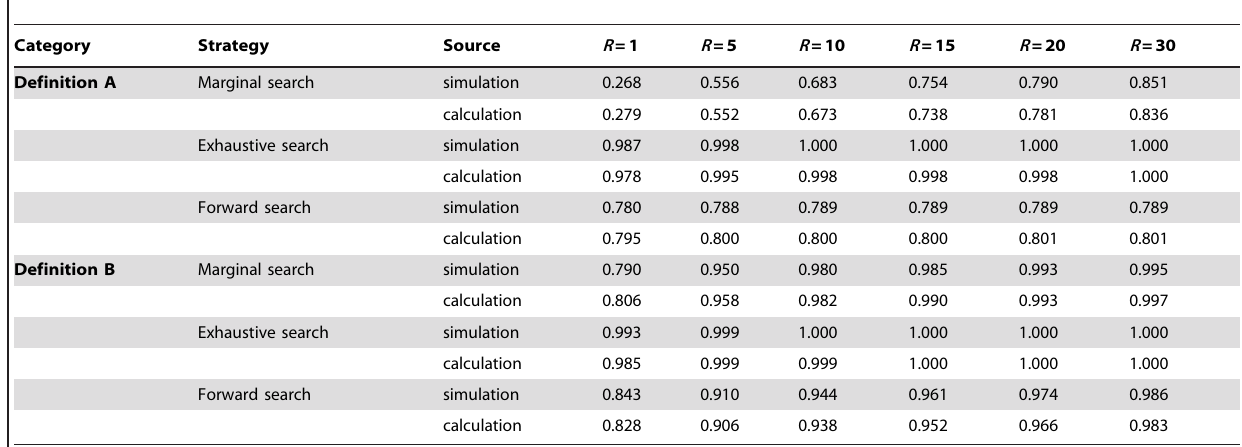
Table 1. The probability of detecting the exact true model (or both true SNPs in marginal search) under power definition A, and the probability of detecting at least one of the true SNPs under power definition B, with the false discovery number R varying. b 1 = b 2 =0.1, b 3 =